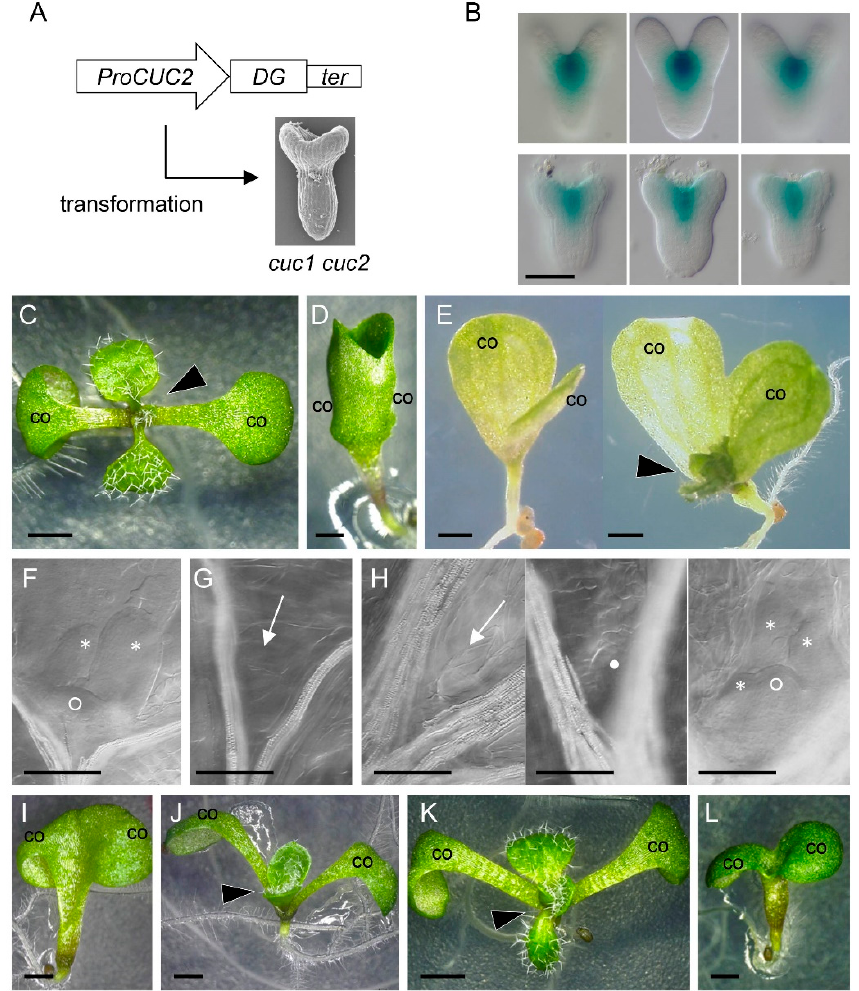
Figure 2. Rescue of cuc1 cuc2 phenotype by candidate downstream genes. ( A ) Schematic diagram of rescue experiments. CUC2 promoter ( ProCUC2 ), cDNA of downstream gene ( DG ), and nos terminator ( ter ). ( B ) CUC2 promoter activity detected by β‐ glucuronidase (GUS). Longitudinal views of GUS ‐ stained wild ‐ type Col ( top ) and cuc1 ‐ 5 cuc2 ‐ 3 ( bottom ) embryos in three different optical sections, showing expression in the boundary region. ( C , D ) Seedlings of wild ‐ type Col ( C ) and cuc1 ‐ 5 cuc2 ‐ 3 ( D ), 7 days after germination (dag). Wild type has two separated cotyledons (co) and develops a shoot between them (arrowhead), whereas cuc1 ‐ 5 cuc2 ‐ 3 has cotyledons (co) fused along their margins. ( E ) A cuc1 ‐ 5 cuc2 ‐ 3 seedling mildly rescued by the STM transgene at 9 dag ( left ) and 16 dag ( right ). Cotyledons (co) are partially fused on one side. Note that the shoot is only visible at 16 dag (arrowhead). ( F , G ) Shoot apices in cleared seedlings (11 dag) of wild type ( F ) and cuc1 ‐ 5 cuc2 ‐ 3 ( G ). Wild type develops the shoot meristem (open circle) and leaf primordia (asterisks), whereas cuc1 ‐ 5 cuc2 ‐ 3 lacks these structures at the corresponding postion (arrow). ( H ) Shoot apices in cleared seedlings (11 dag) of cuc1 ‐ 5 cuc2 ‐ 3 rescued by STM , showing variable phenotypes: no visible shoot meristem and leaf primordia ( left , arrow), small undifferentiated tissue ( middle , closed circle), and shoot meristem with leaf primordia ( right , open circle, and asterisks). ( I – L ) cuc1 ‐ 5 cuc2 ‐ 3 seedlings (9 dag) rescued by combined transgenes: STM and LAS ( I , J ), STM and BLR ( K ), and STM and KNAT6 ( L ). Arrowheads represent emerging shoot. co, cotyledon. Bars = 50 μ m ( B , F – H ); 1 mm ( C – E , I – L ).